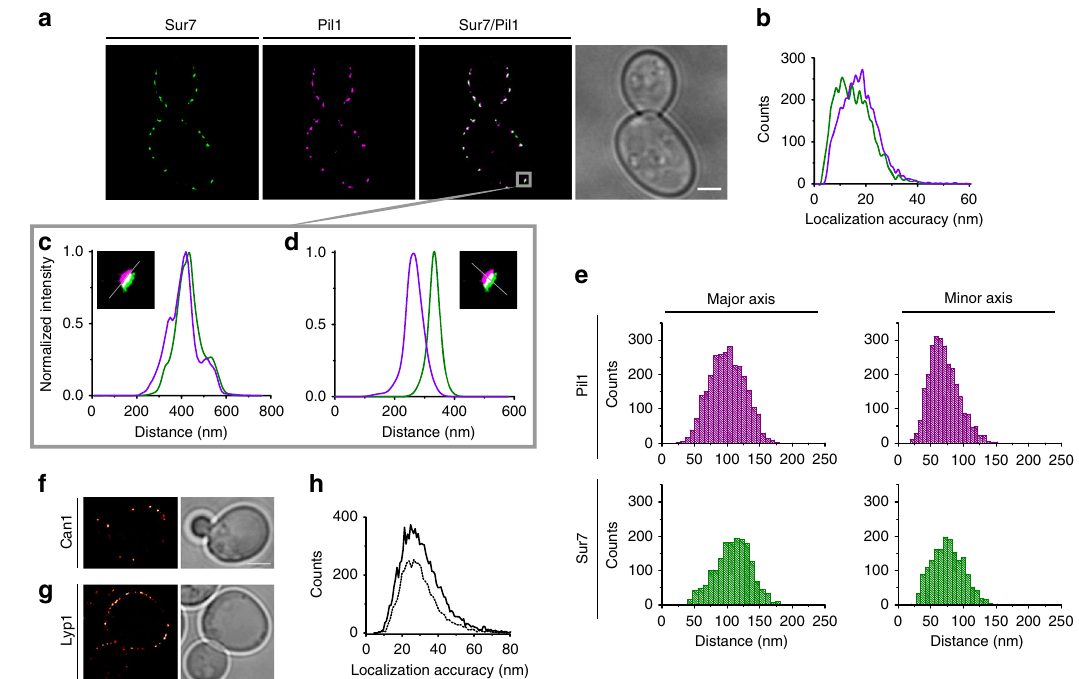
Fig. 1 High-resolution plasma membrane protein localization. a Dual-color super-resolution reconstructions of Sur7-YPet in green and Pil1-mKate2 in magenta. Co-localizations appear in white. b The localization accuracy of the fl uorophores YPet (green) and mKate2 (magenta) were estimated from the fi tting error. c , d Eisosome line scans measured along ( c ) and perpendicular ( d ) to the plasma membrane. e Histograms of the distribution of the size of eisosomes on the basis of localizations of Pil1 or Sur7 ( n = 302). Single-color super-resolution reconstructions of f Can1-mEos3.1 and g Lyp1-mEos3.1 with h their respective fi tting errors (drawn line, Lyp1; dotted line, Can1). All proteins were chromosomally tagged with the respective fl uorophores. Scale bar represents 2 µ m; n represents the number of cells